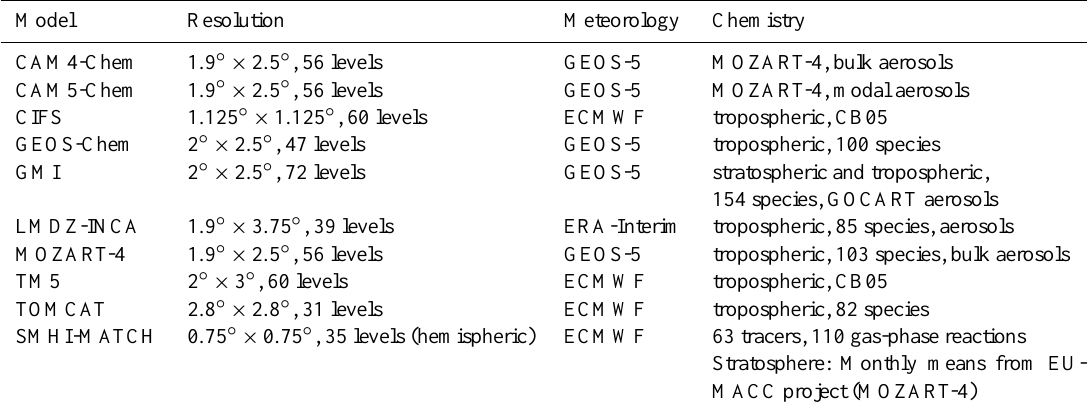
Table 1. Description of POLMIP